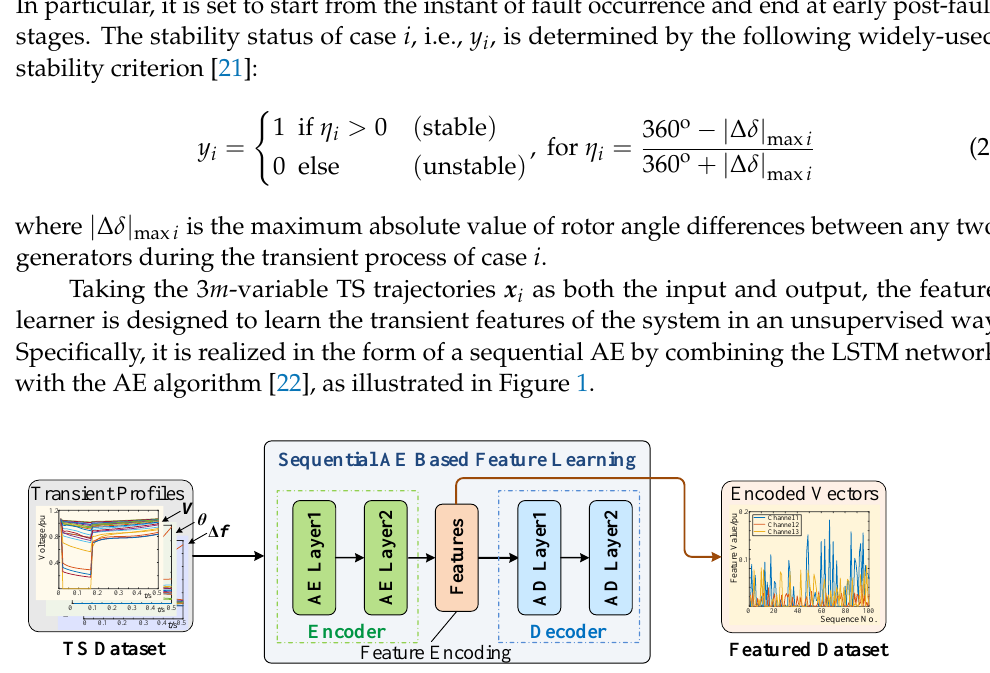
Figure 1. Sequential AE-based system feature